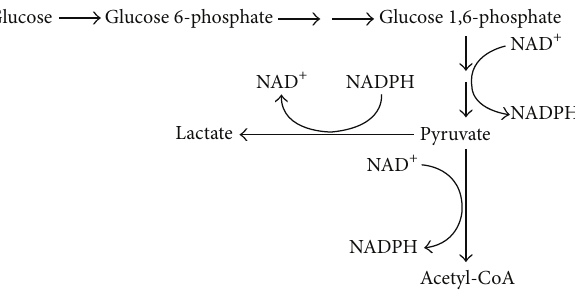
Figure 7: Consumption and regeneration of NAD +